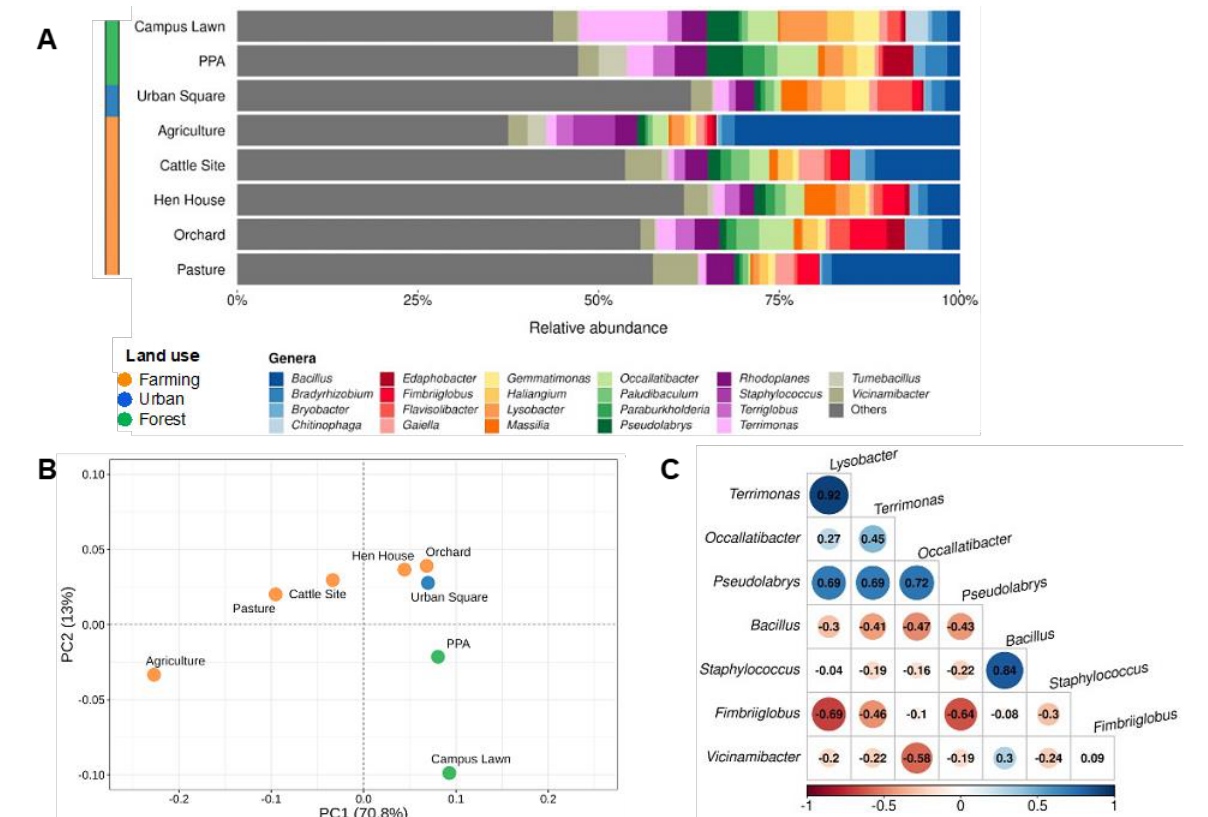
Figure 1. Most abundant taxa and their distributions throughout the study sites at genera level. ( A ) Relative abundances of groups found in environmental samples according to 16S sequencing. All taxa found with relative abundances below 2.5% in each sample were labeled as “Others”. ( B ) Principal component analysis (PCA) of most abundant bacteria, clustered together per sampling site and colored according to land-use classification. ( C ) Correlogram indicating negative (in red) and positive (in blue) correlations among most abundant taxa (minimum relative abundance of 5%) in the studied sites.